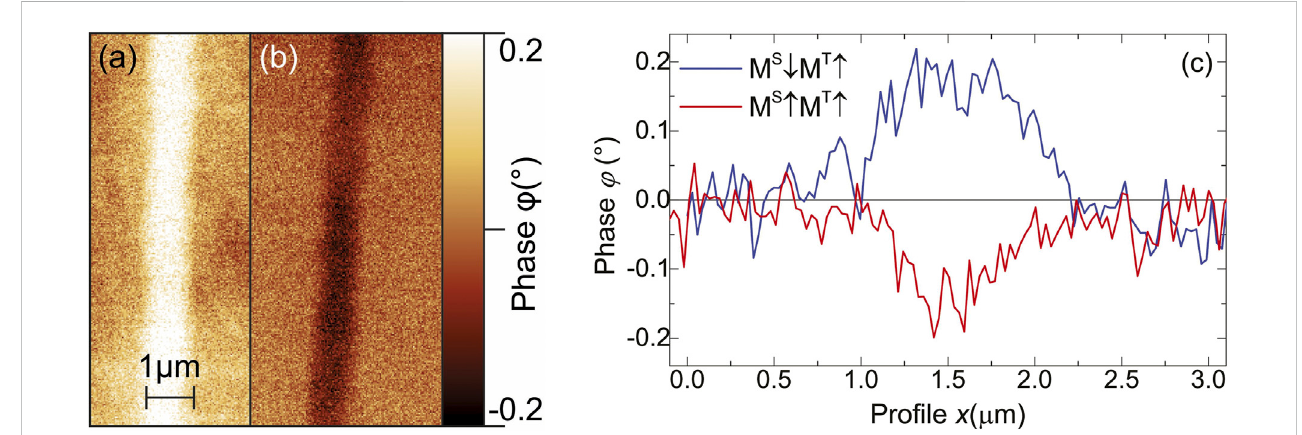
FIGURE 3 Magneticforcemicroscopymeasurementsofthesample(M S )andtip(M T )magnetizationinantiparallel (A) andparallel (B) directionswithrespecttoeach other; (C) corresponding line